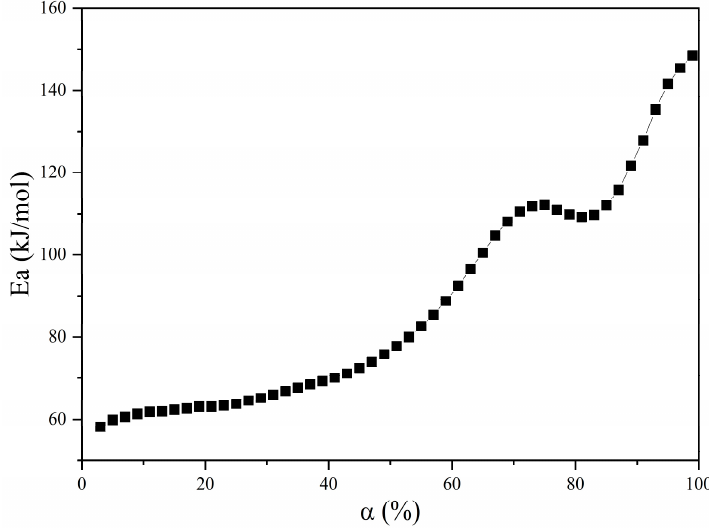
Figure 4. Effective activation energy as a function of conversion of SITEUP/IPDA.